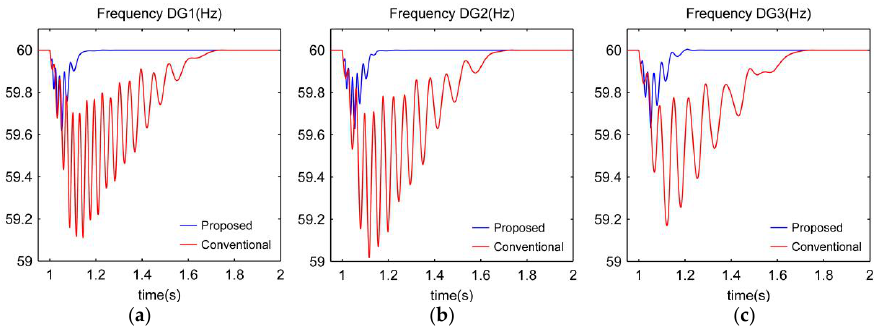
Figure 15. Power sharing of DG’s during islanding using proposed supplementary control compare with conventional droop controller ( a ) DG1; ( b ) DG2; and ( c ) DG3.